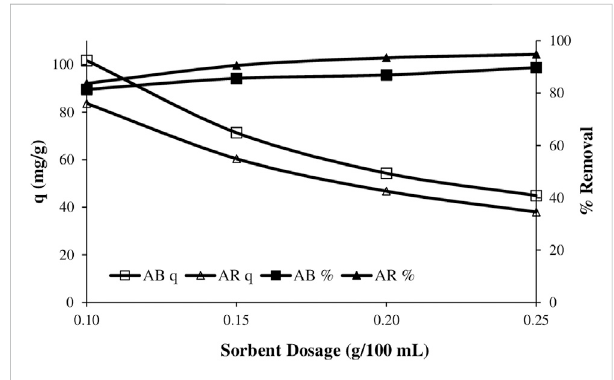
Figure 7 The variation of the amount adsorbed and the removal percentage with sorbent